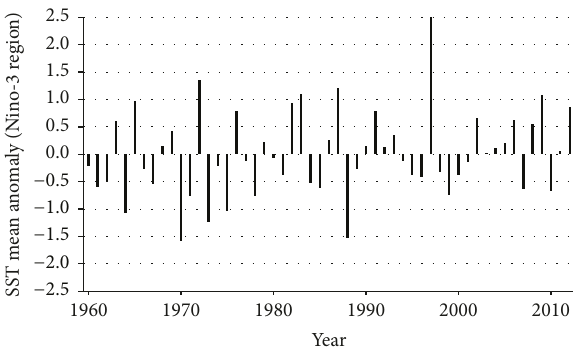
Figure 5: SST anomalies over Nino–3 region for JJAS season from 1960 to 2010.